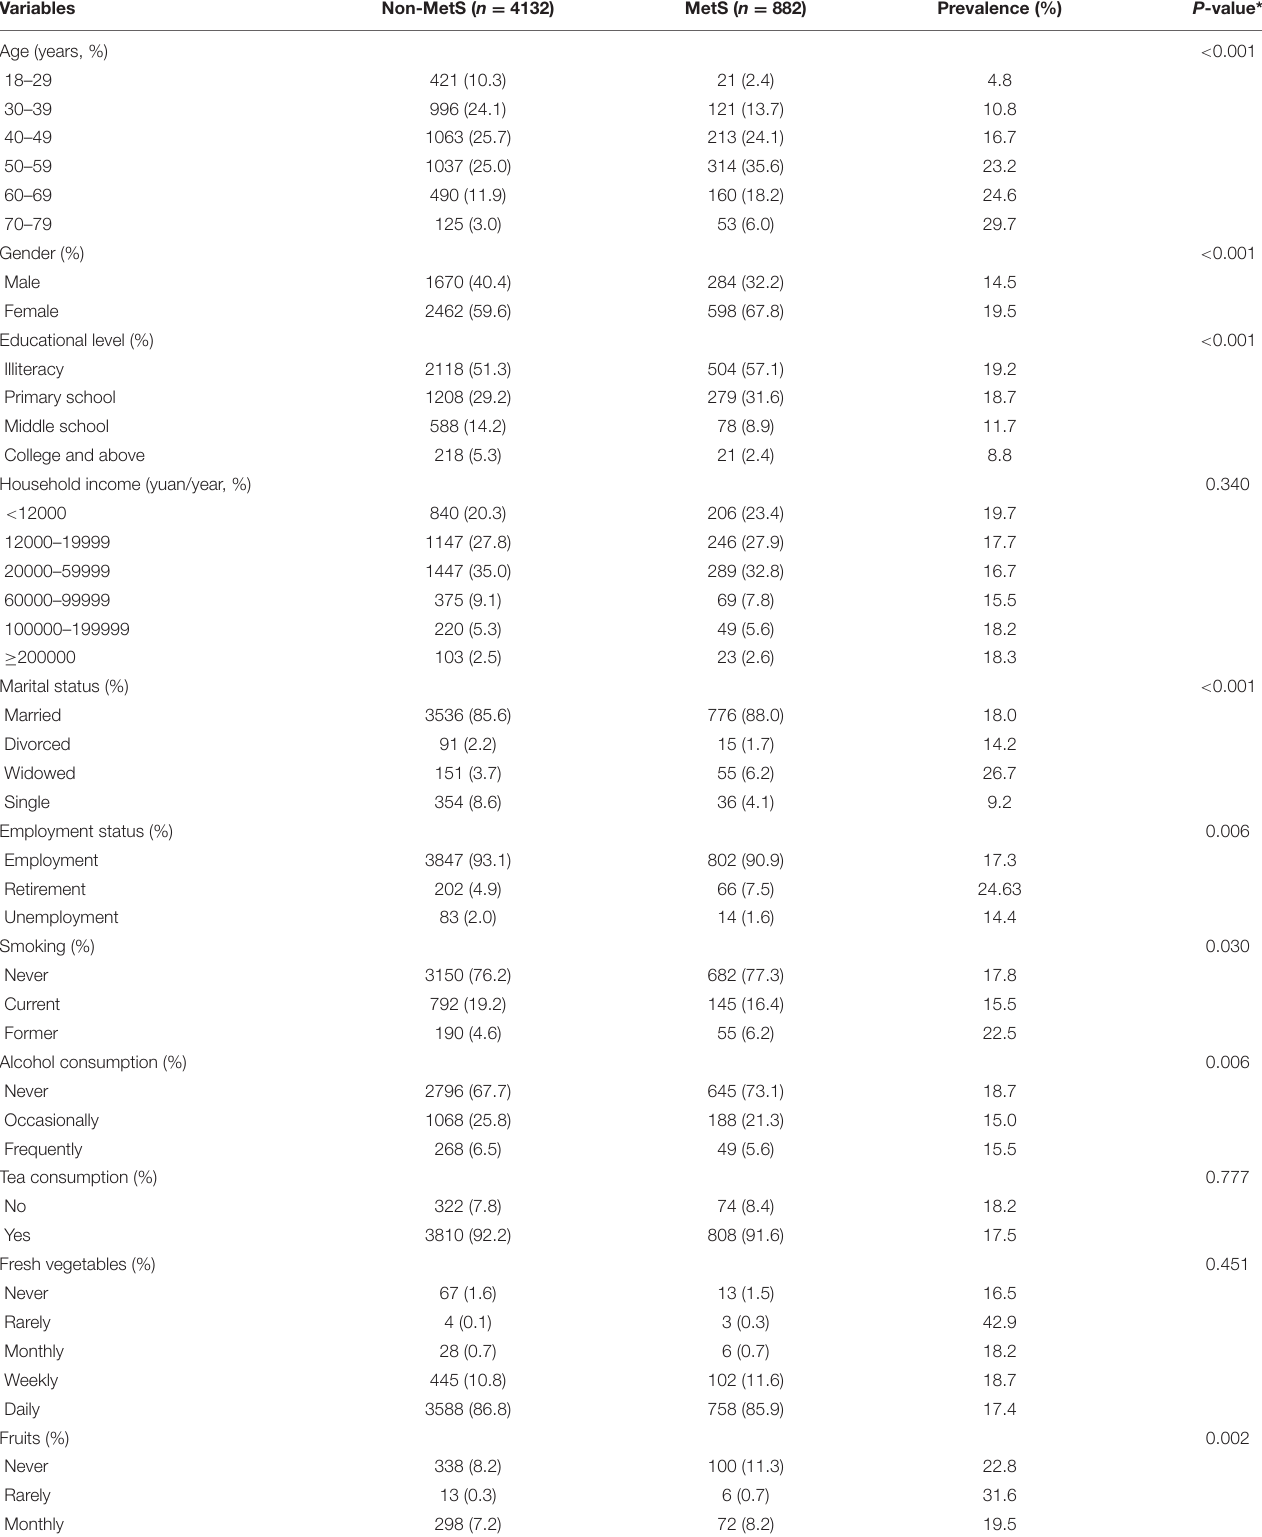
TABLE 1 | Characteristics of metabolic syndrome (MetS) and non-MetS